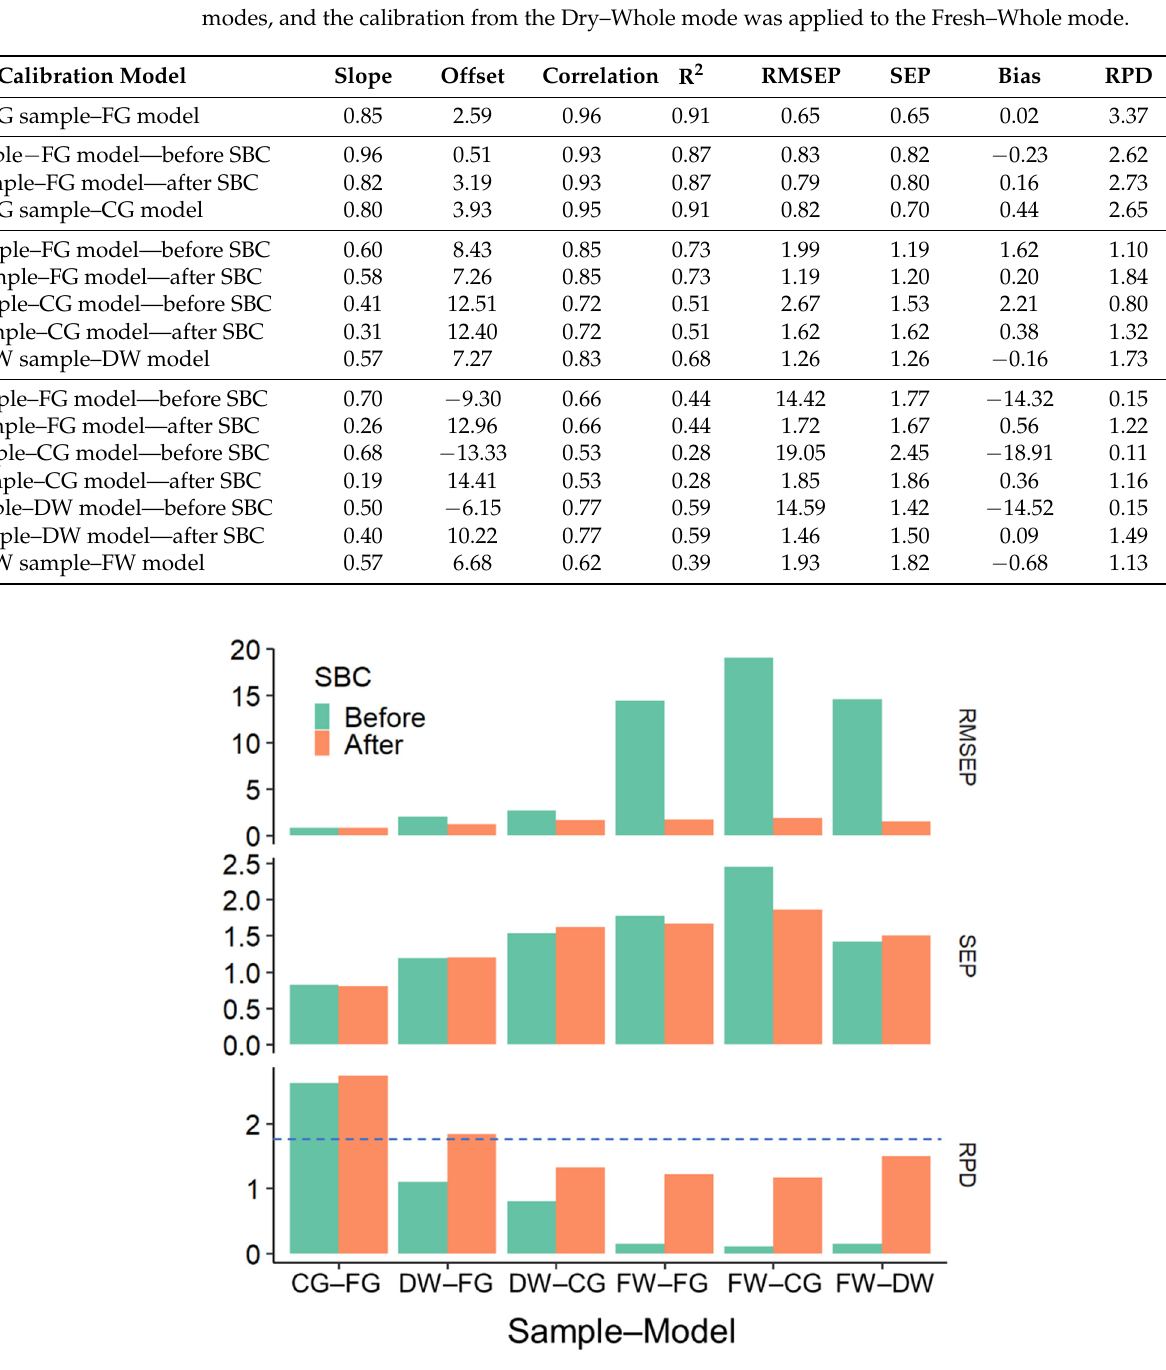
Figure 7. The root mean square error of prediction (RMSEP), standard error of prediction (SEP), and the residual prediction deviation (RPD) values before and after slope and bias correction (SBC), predicting samples in satellite modes using Fine–Ground (FG), Coarse–Ground (CG), and Dry–Whole (DW) models. RMSEP and SEP values decrease after SBC, and RPD values increase after SBC.